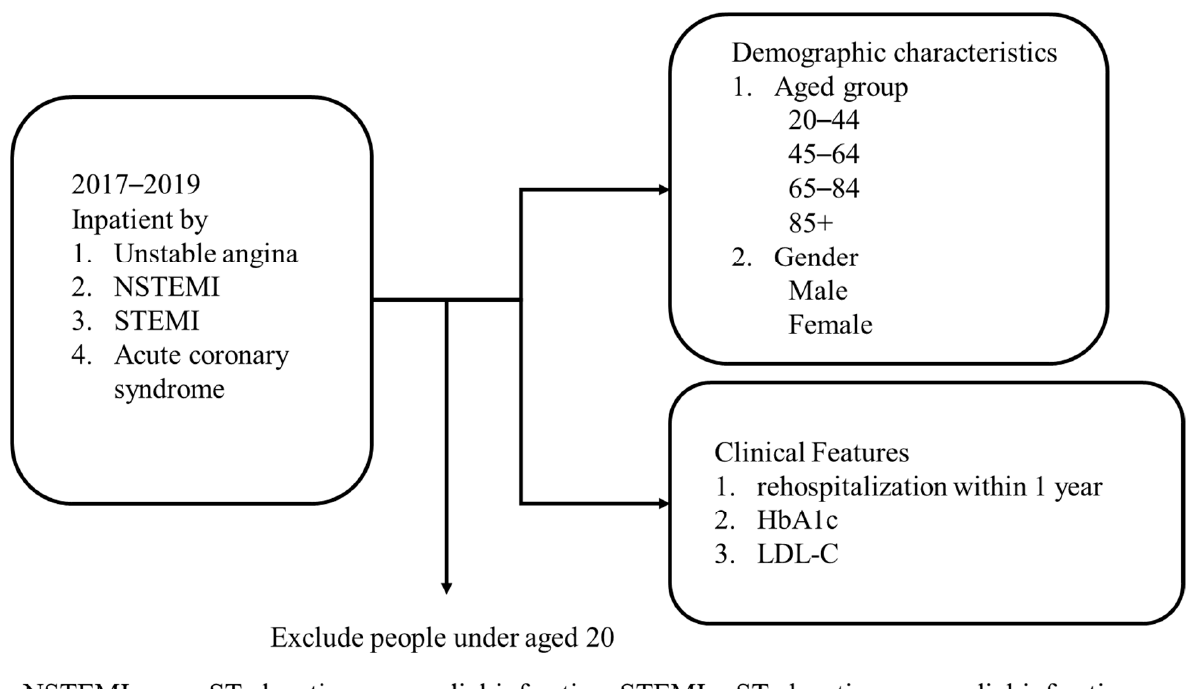
Figure 1. The process of the study population in the hospital.